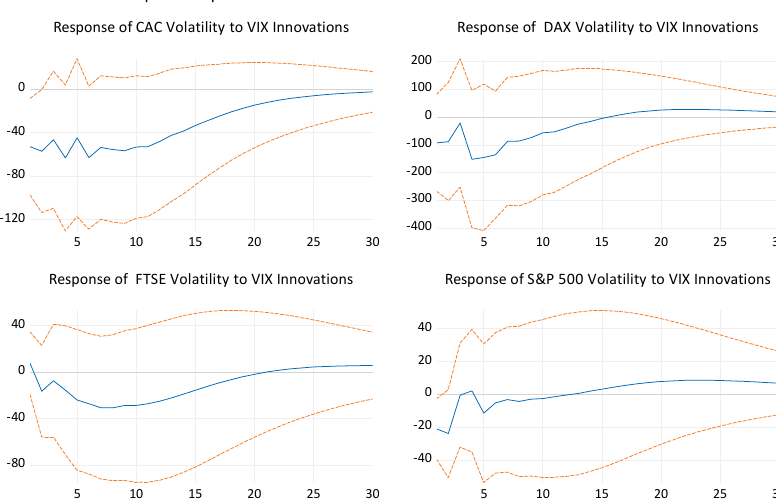
Figure 8. Responses of volatility in equity indices to structural innovations in VIX. Estimates and two standard deviation confidence band are in solid and dotted lines. SVAR lag order is one. 18 May 2016 − 13 February 2017.